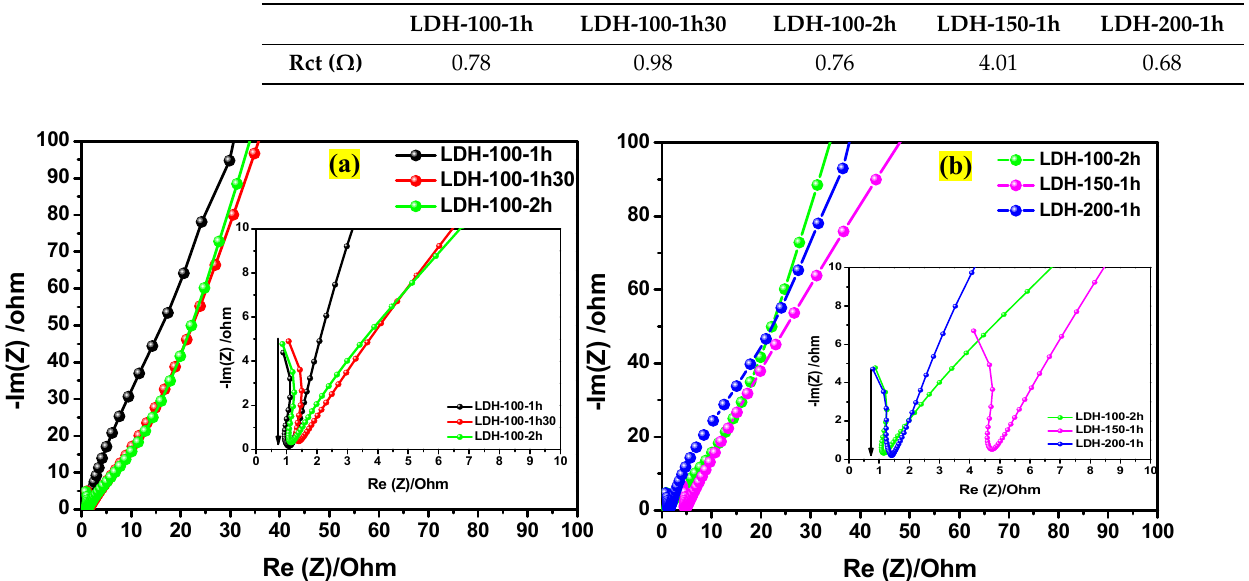
Figure 9. ( a ) Nyquist plots for the LDH-100-1h, LDH-100-1h30, and LDH-100-2h electrodes; and ( b ) Nyquist plots for the LDH-100-2h, LDH-150-1h, and LDH-200-1h electrodes. Table 3. Capacitance performance of various NiCoAL-LDH-based electrode.